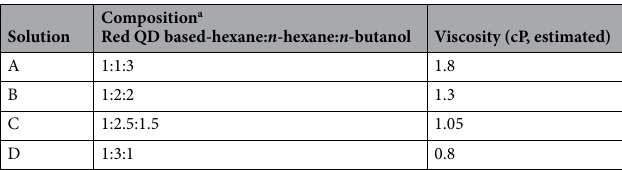
Table 2. Composition and viscosity of QD solutions. a Volume